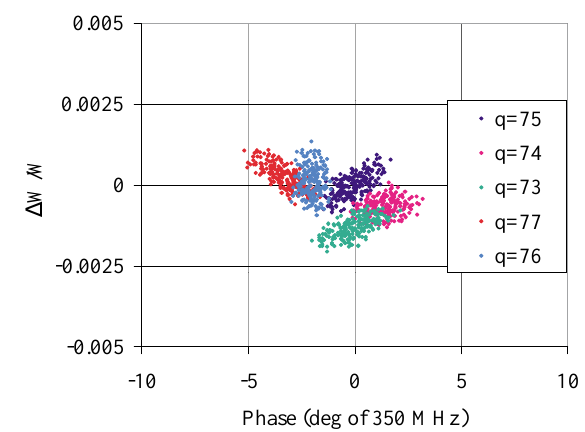
FIG. 7. (Color) Phase space plots of five charge state beam at 85 MeV (cid:2) u before passing through the second stripper.